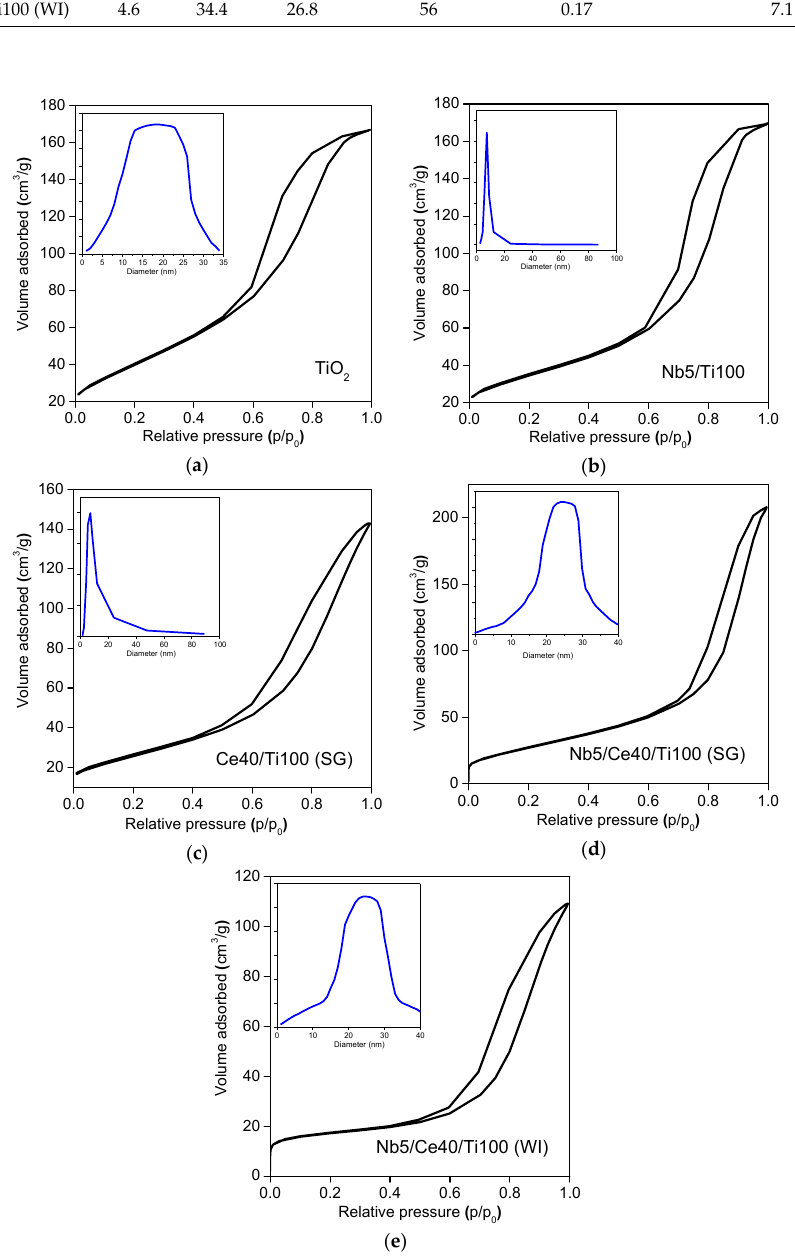
Figure 3. N 2 adsorption-desorption isotherms and BJH pore distributions for all fresh catalysts: ( a ) TiO 2 , ( b ) Nb5/Ti100, ( c ) Ce40/Ti100 (SG), ( d ) Nb5/Ce40/Ti100 (SG), ( e ) Nb5/Ce40/Ti100